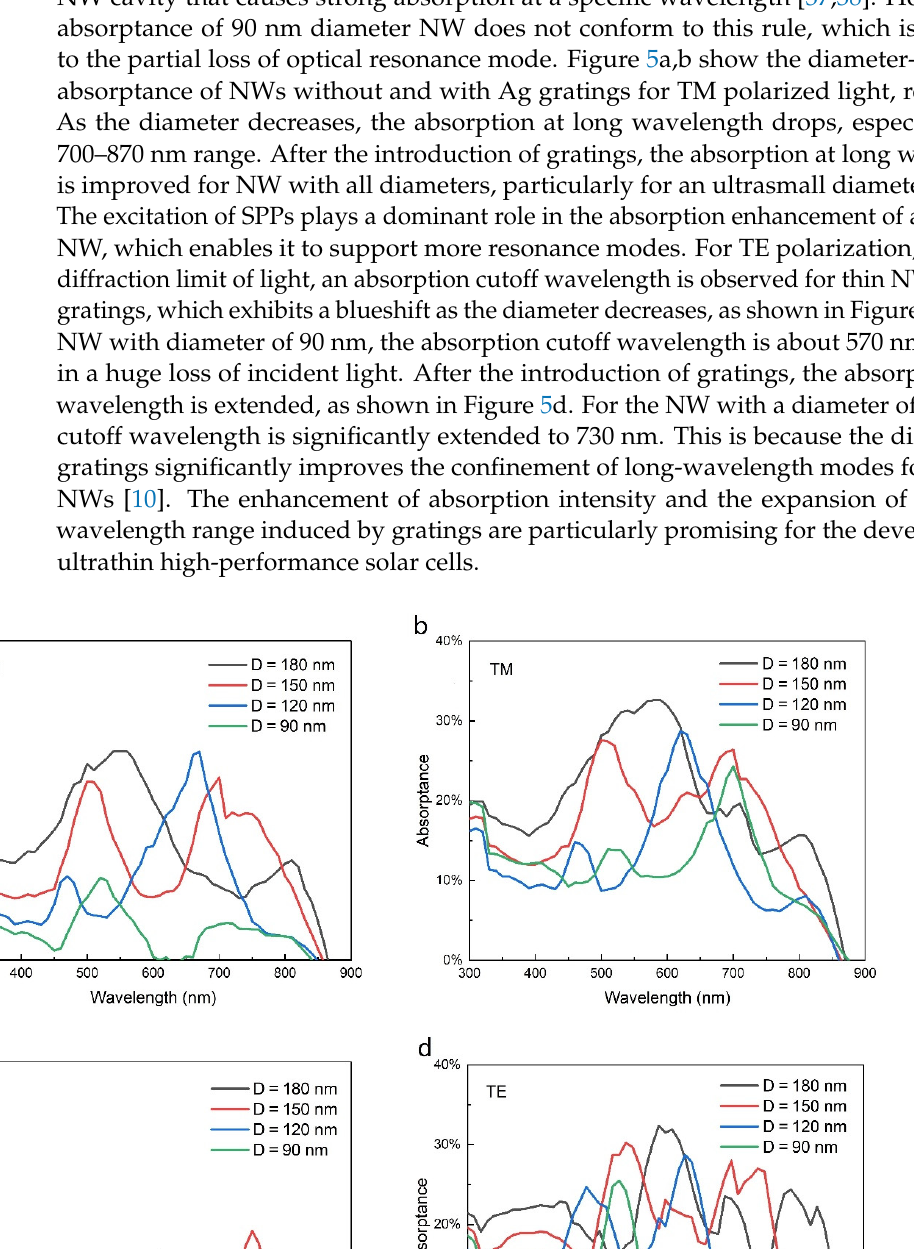
Figure 6. The current–voltage characteristics of NWs with different diameters. The grating period is 400 nm.